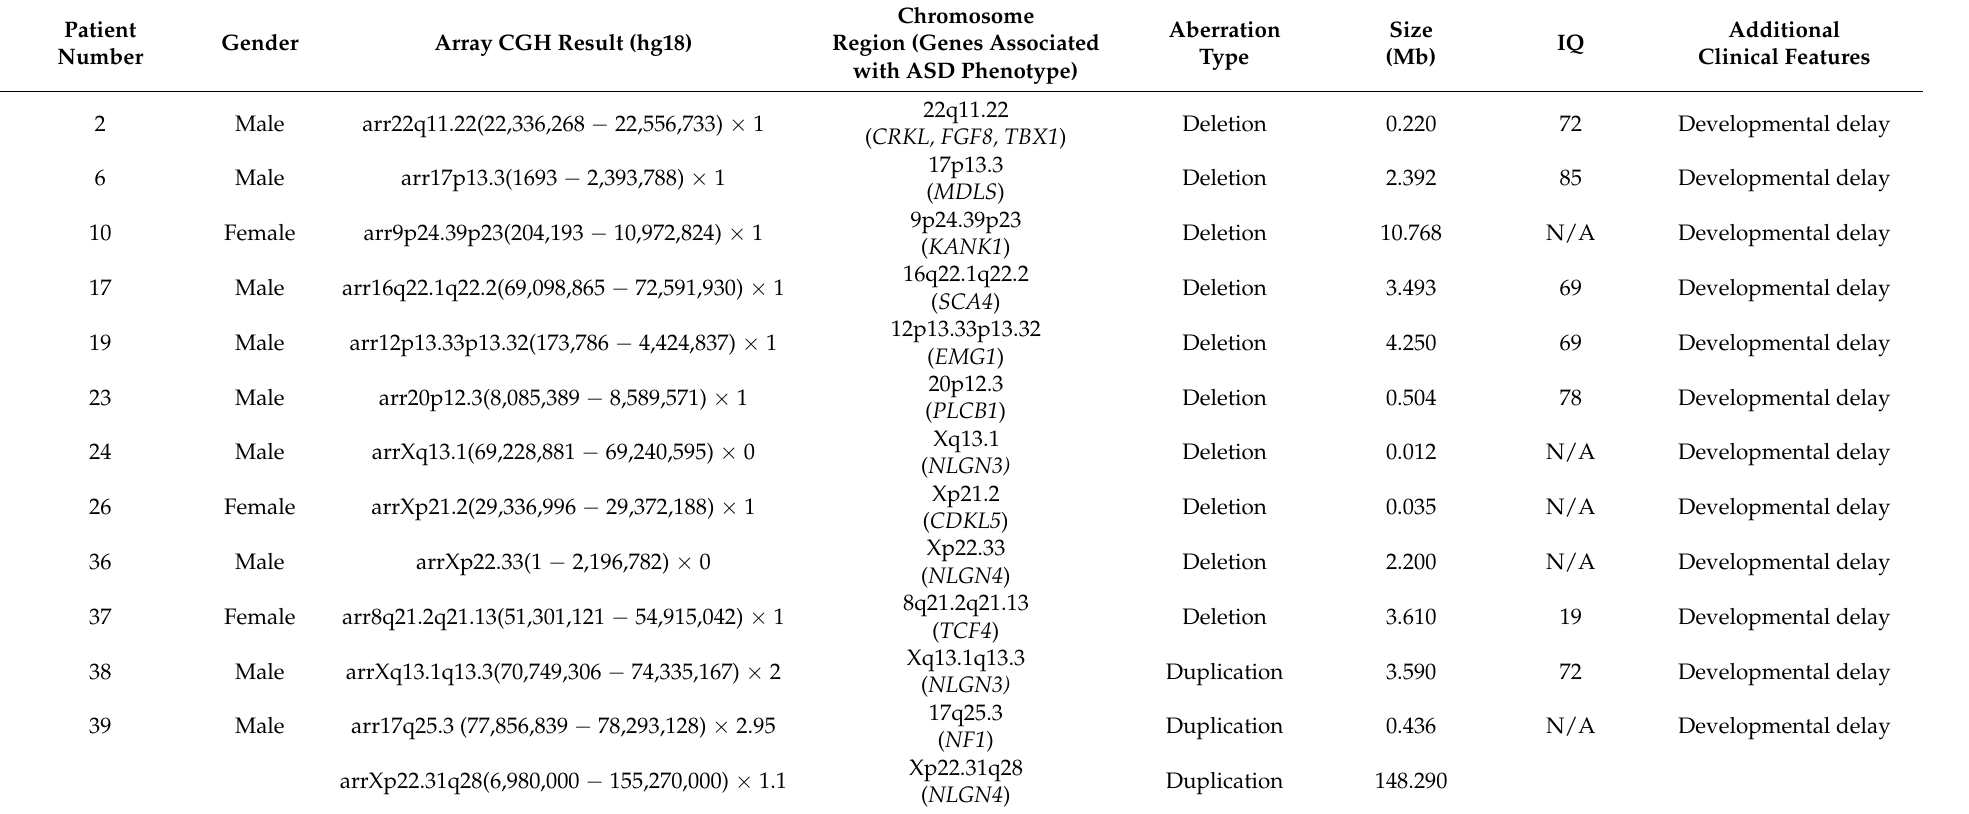
Table 3. List of variants of uncertain